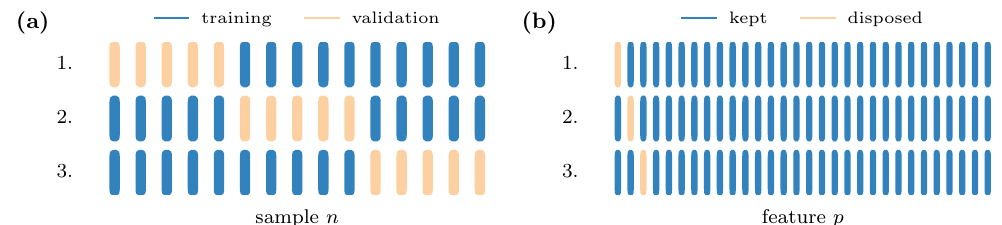
Figure 5. The first three iterations in different cross-validation types applied on a 15 × 30 dataset: ( a ) k -fold cross-validation with k = 3 and ( b ) LOOCV with k =